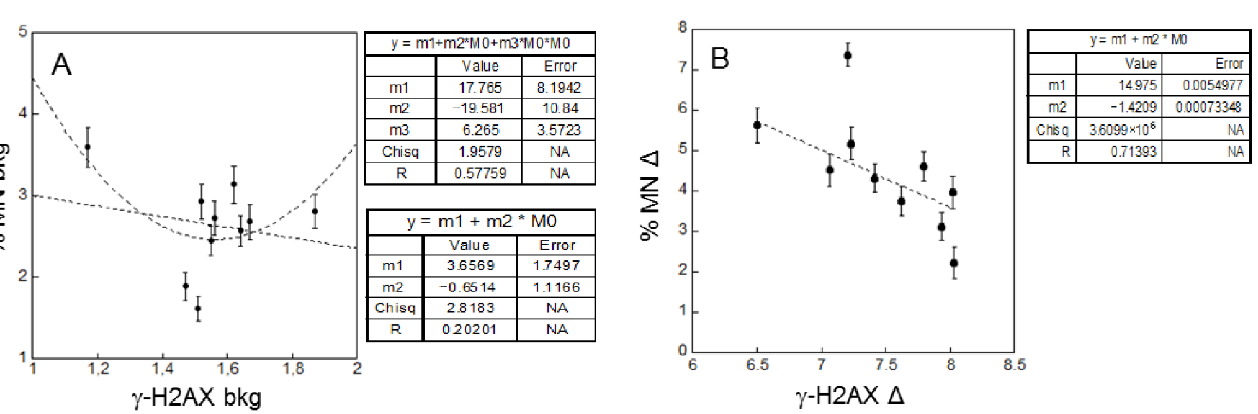
Figure 7. Correlation in healthy donors. ( A ) Background MN frequency versus background level of γ-H2AX. ( B ) Lymphocytes radio-sensitivity (Δ) for MN frequency versus γ-H2AX. The dotted lines represent linear weighed least-squares fits of the data. Error bars represent the propagation of the errors. Background: bkg.